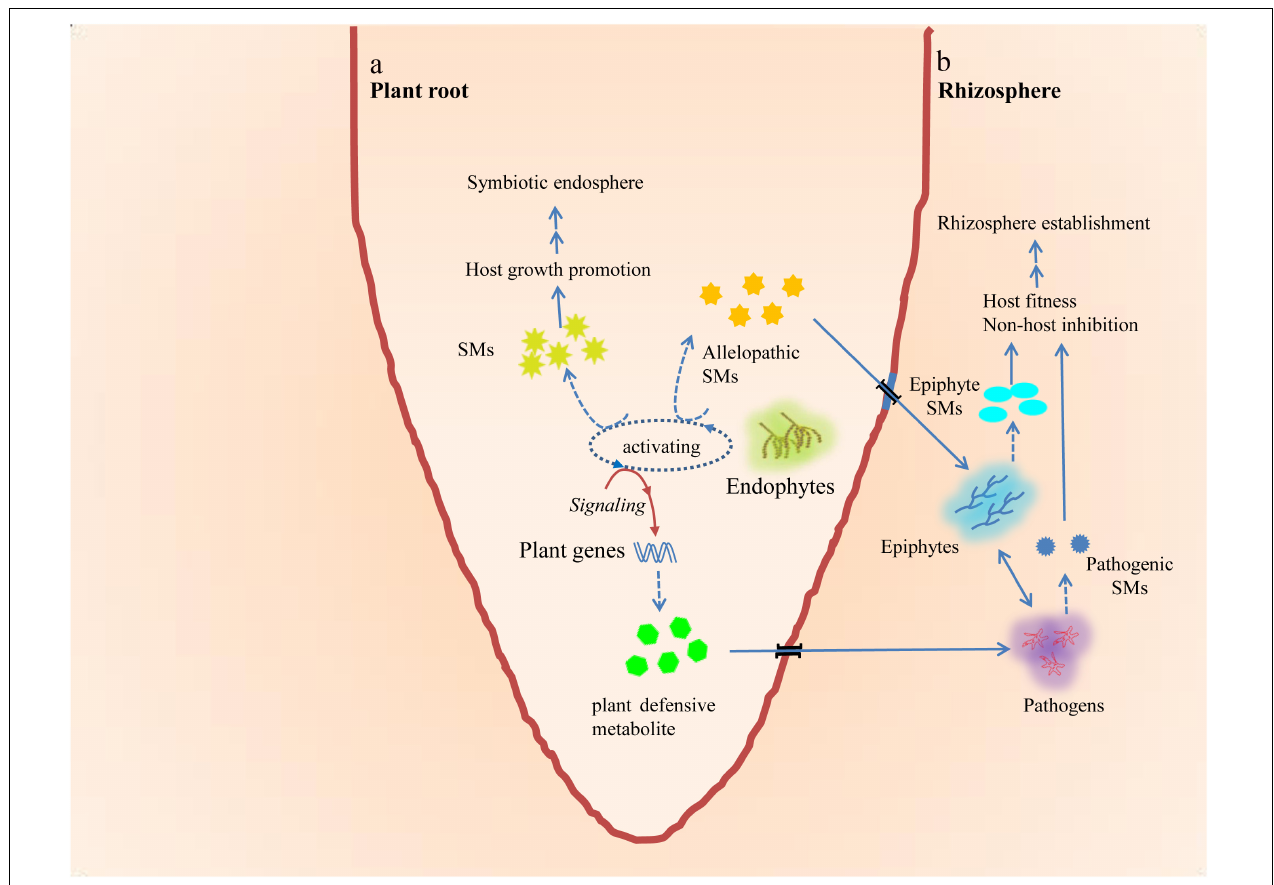
FIGURE 2 | Mutual orientation of microbiome and plant (a) and multidirectional crosstalks or chemical communications among plants, endophytes, epiphytes, and pathogens under natural ecological conditions (b) . Endophytic fungus (EF), EF secondary metabolite (SM), allelopathic SMs, pathogens, pathogenic SM, epiphytes, epiphytic SM, plant defensive